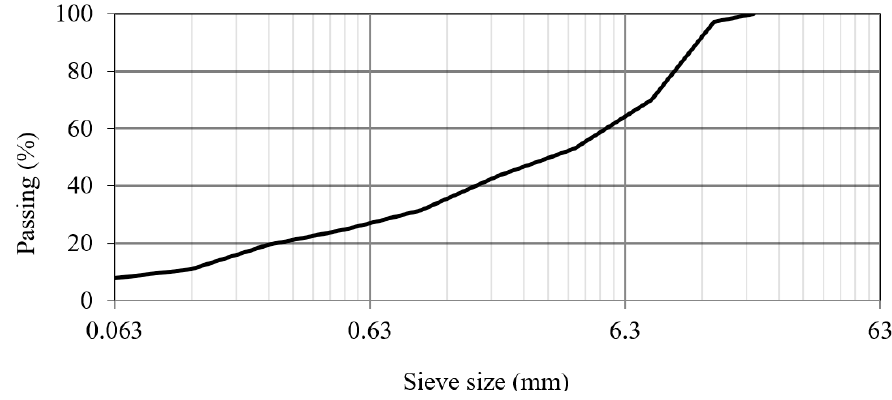
Figure 1. Grading curve of the designed mixture.